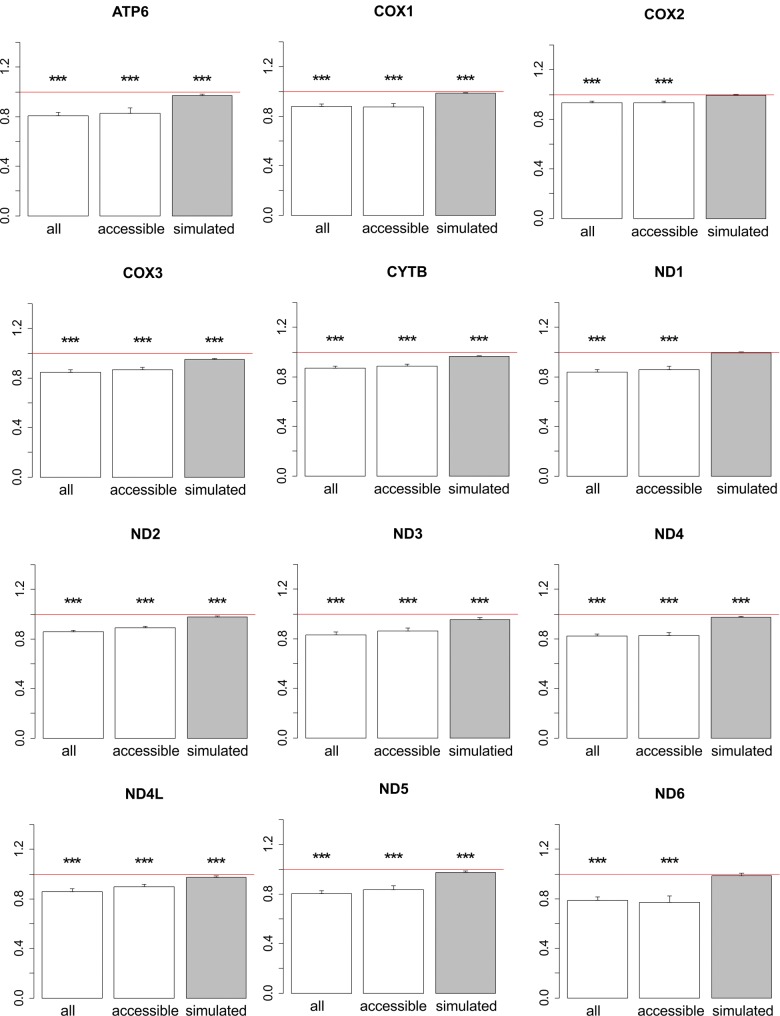
Ratios of phylogenetic distances between parallel and divergent substitutions in metazoan phylogenies. Values below 1 imply that the parallel substitutions are closer at the phylogeny to each other, compared with divergent substitutions. The bar height and the error bars represent respectively the median and the 95% CIs obtained from 1,000 bootstrap replicates, and asterisks show the significance of difference from the one-to-one ratio (red line; ***P < 0.001; no asterisk, P > 0.05). all, real data; accessible, real data only for substitutions from accessible amino acid pairs (see text); simulated, simulated data.